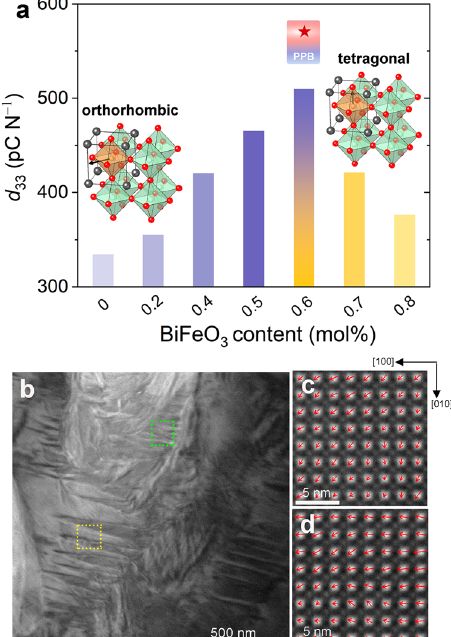
Fig. 1 Piezoelectricity and characterization of the local structure of the studied KNN materials. a Piezoelectric coef fi cient d 33 of the studied KNN compositions x = 0, 0.002, 0.004, 0.005, 0.006, 0.007, and 0.008 (with a BiFeO 3 content of 0, 0.2, 0.4, 0.5, 0.6, 0.7, and 0.8 mol%, respectively). The optimal piezoelectricity is obtained at the orthorhombic-tetragonal phase boundary, known as the PPB. b High-magni fi cation angular bright- fi eld (ABF) image of composition x = 0.006 taken along the [100] zone axis. electron microscopy (HAADF-STEM) image taken along the crystallographic [001] zone axis, obtained from the regions highlighted by green and yellow dashed squares, respectively, in b . Mapping of the polar vectors is represented by the red arrows. The positions of the atomic columns of the perovskite A-sites and B-sites can be identi fi ed by fi tting with two- dimensional Gaussian peaks so that the atomic displacement from the B-site cation to the center of the nearest A-site cations can be